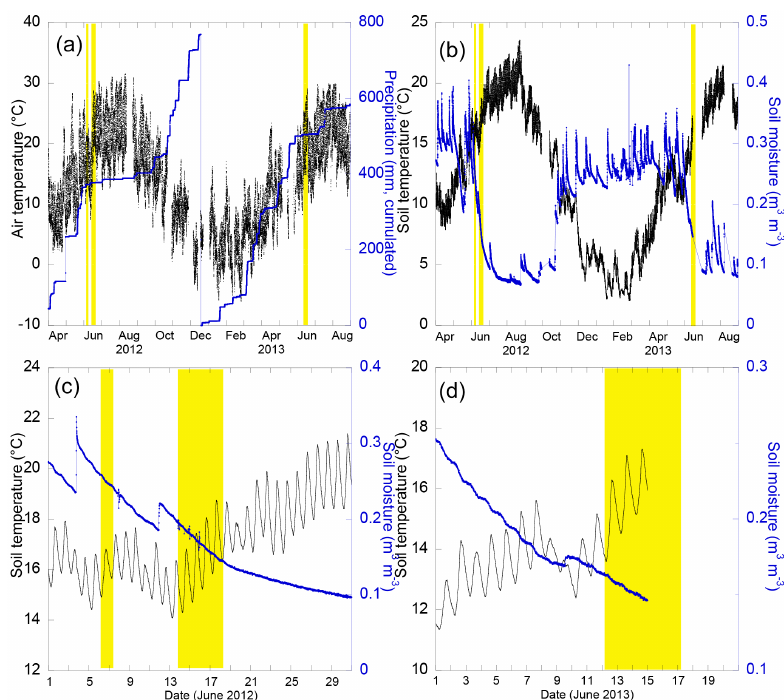
Figure 1. Monthly variations (a) in air temperature and cumulated precipitations and (b) in soil temperature and moisture ( − 10cm) at an oak forest ecosystem in southern France (O3HP). (c, d) Same as panel (b) but for June 2012 and June 2013. The yellow vertical bands correspond to the sampling